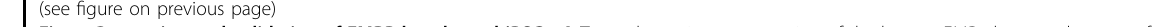
Fig. 1 Generation and validation of FMRP knock-out hiPSCs. A Top: schematic representation of the human FMR1 locus and strategy for gene editing. The red triangle represents the site of cleavage by Cas9. The selection cassette, shown below, encodes for the self-cleavage peptide (T2A) and the puromycin resistance gene (PURO-resistance) and contains a cleavage and polyadenylation signal (pA). Primers used for the PCR analysis on genomic DNA are depicted as arrows. Bottom: PCR analysis on genomic DNA of hiPSCs transfected with the donor construct only ( fi rst lane) or co- transfected with the Cas9 and gRNA#1 or gRNA#2 (second and third lanes). B PCR analysis on genomic DNA of the indicated hiPSC clones with primers indicated in panel A . C RT-PCR analysis on RNA isolated from the indicated hiPSC clones with primers spanning exon – exon junctions. The housekeeping gene ATP5O was used as an internal control. D Top: Western blot analysis of FMRP expression in the indicated hiPSC clones. GAPDH was used as loading control. Bottom: immunostaining analysis in parental and FMRP-KO hiPSCs. Red: FMRP; blue: DAPI. Scale bar: 500 μ m. E Real-time qRT-PCR analysis of cortical neurons derived from parental and FMRP-KO hiPSCs ( n = 3 differentiation batches; Student ’ s t test; paired; two tails; * p < 0.05, *** p < 0.001). F Western blot analysis of FMRP expression in cortical neurons derived from parental and FMRP-KO hiPSCs. GAPDH was used as loading